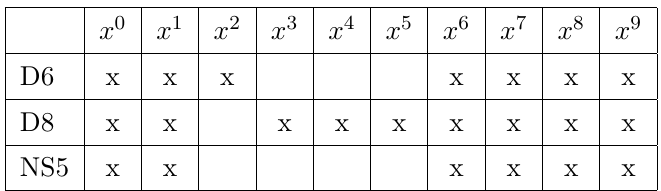
-BPS brane intersection underlying the 6d (1 , 0) CFTs living in D6-NS5-D8 brane Table 2 . 1 4 intersections. The directions ( x 0 , x 1 , x 6 , x 7 , x 8 , x 9 ) are the directions where the 6d CFT lives. x 2 is the field theory direction, along which the D6-branes are stretched. ( x 3 , x 4 , x 5 ) are the directions realising the SO(3) R-symmetry.